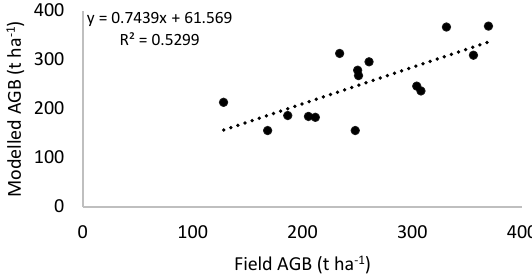
Figure 7: - Linear regression between modelled biomass (y axis) and field biomass (x axis) for the 15